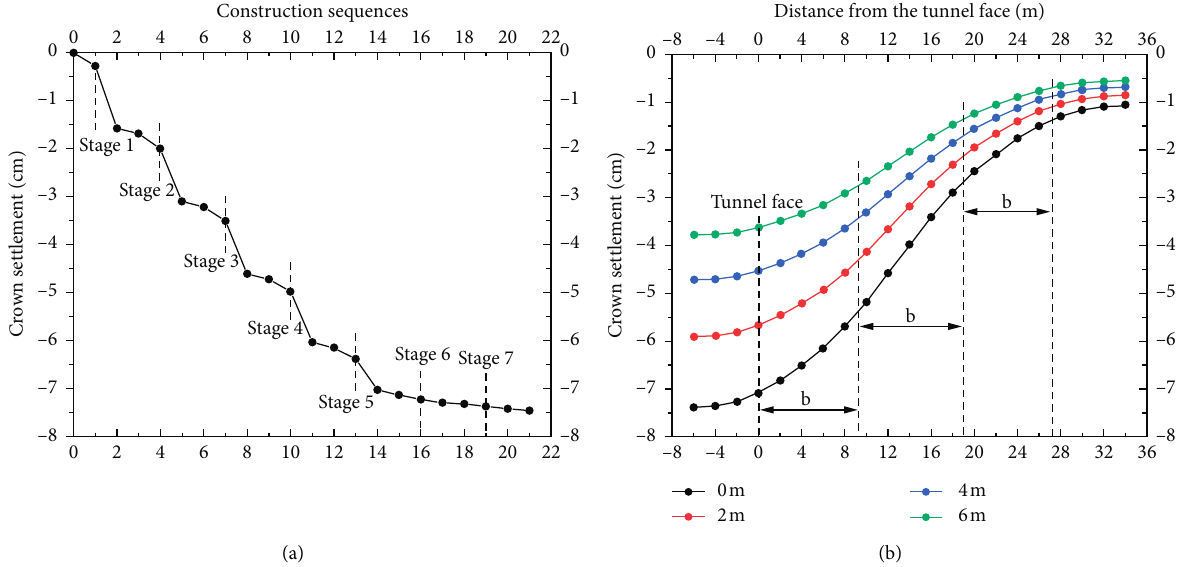
Figure 11: Characteristics of crown settlement of tunnel (tunnel face: section x � 50m). Crown settlement with (a) construction sequences and (b) distance from the tunnel face.